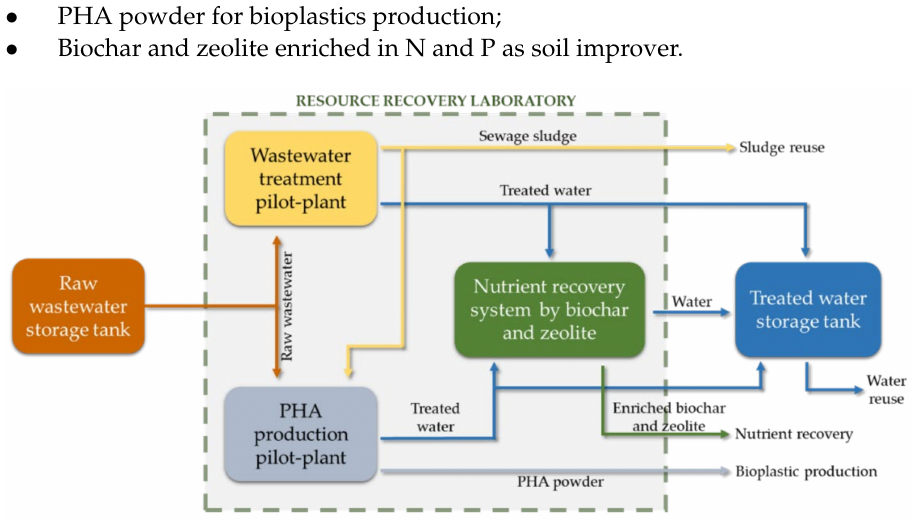
Figure 3. Schematic representation of the resource recovery laboratory. The plants and systems realized in the laboratory will be described in the sections